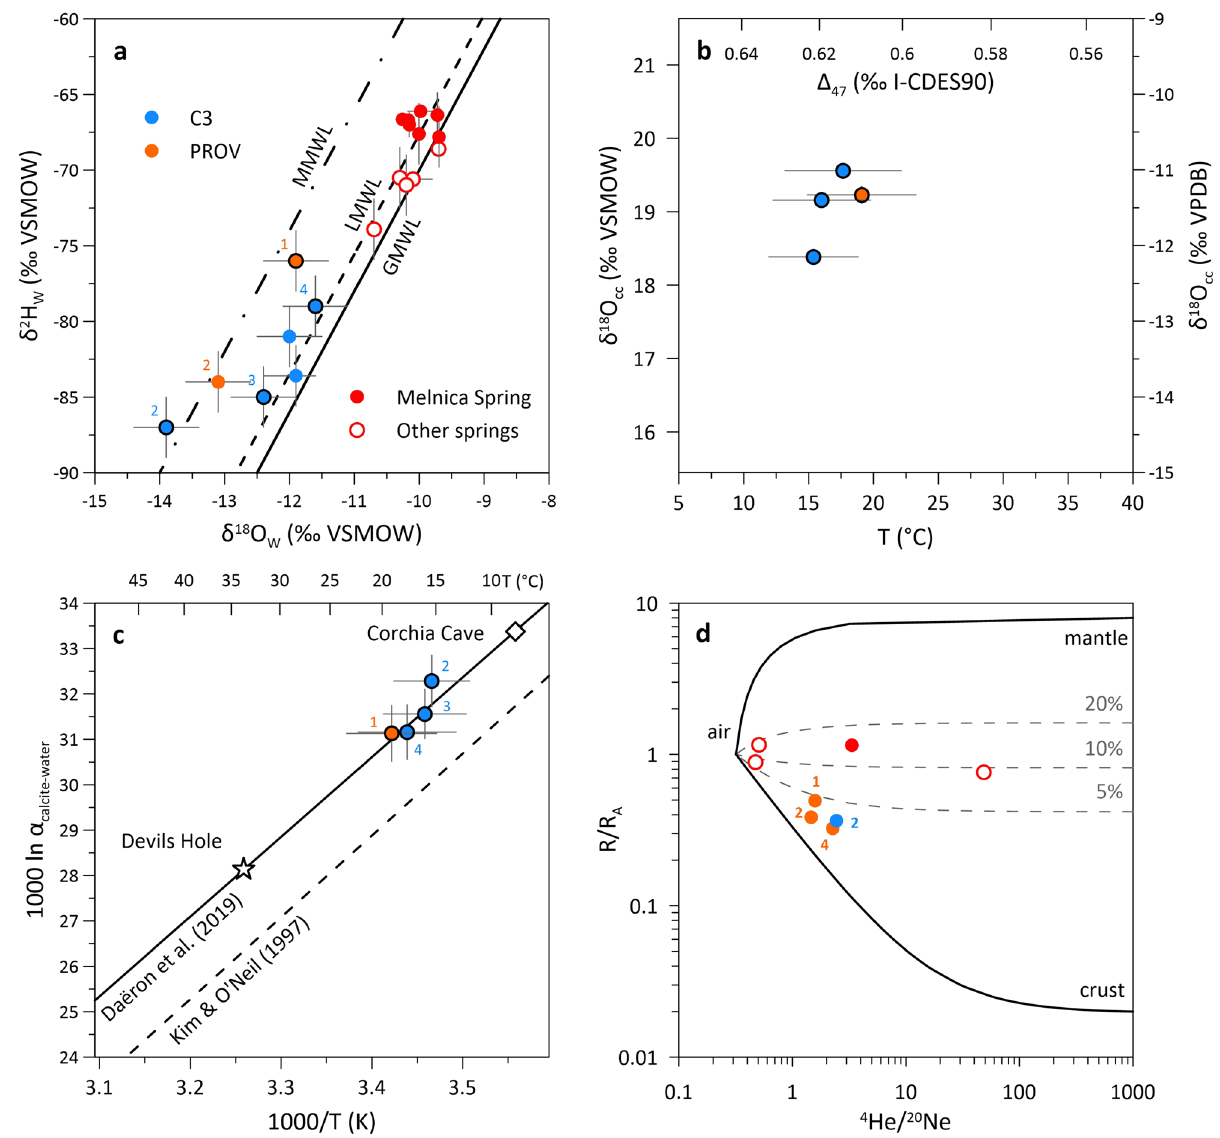
Figure 5. Isotope composition of carbonate and fluid inclusions from Provalata Cave calcite. ( a ) Water stable isotope composition (δ 18 O w , δ 2 H w ). Global (GMWL), Mediterranean (MMWL) and local (LMWL 46 ) meteoric water lines are included. Samples for which both carbonate and water stable isotope data are available have black outlines. ( b ) Carbonate stable isotope composition (δ 18 O cc , Δ 47 ) and clumped based apparent temperatures. ( c ) Calcite-water oxygen fractionation factors for Provalata Cave calcite compared to equilibrium curves of Kim and O’Neil 67 and Daëron et al. 31 . ( d ) Helium isotope composition (R/R A , where R and R A are the 3 He/ 4 He ratio of the sample and air respectively) in a three-component helium mixing plot (atmospheric He: R/R A = 1, 4 He/ 20 Ne = 0.318, crustal He: R/R 4 He/ 20 Ne = 1000, mantle He: R/R 4 He/ 20 Ne = 1000 64–66 ). Numbers A = 0.02, A = 8, indicate stratigraphic position of the subsample within the calcite coating